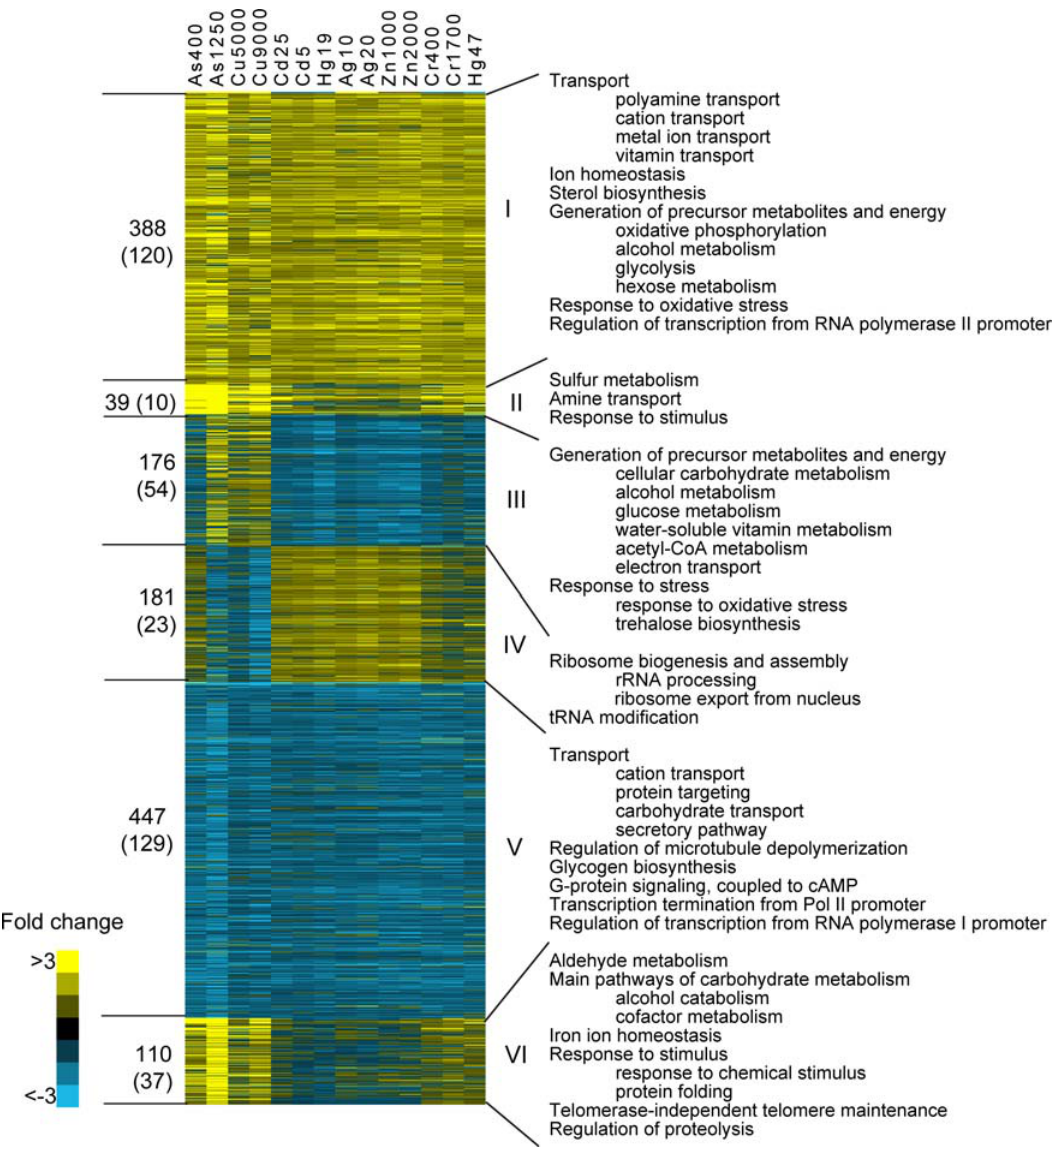
Figure 2. K-means cluster of differentially expressed genes and selected enriched Gene Ontology terms. K-means clustering on the average fold-change in gene expression values was performed with K=6 for the genes, K=3 for the samples Euclidean distance as the similarity metric. Metal species with concentration values ( m M) are presented at the top of each column. The values on the left side of the heat map denote the number of genes in each cluster, with the values in the parenthesis indicating the number of genes with unknown Gene Ontologies. Expression values, measures of significance, and corresponding Gene Ontologies for the genes and clusters presented in this Figure can be found in Tables S1 and S2, respectively. The hierarchical cluster presented at the top of the heat-map was calculated using the 1,341 differentially expressed genes dataset used in the K-means clustering analysis.